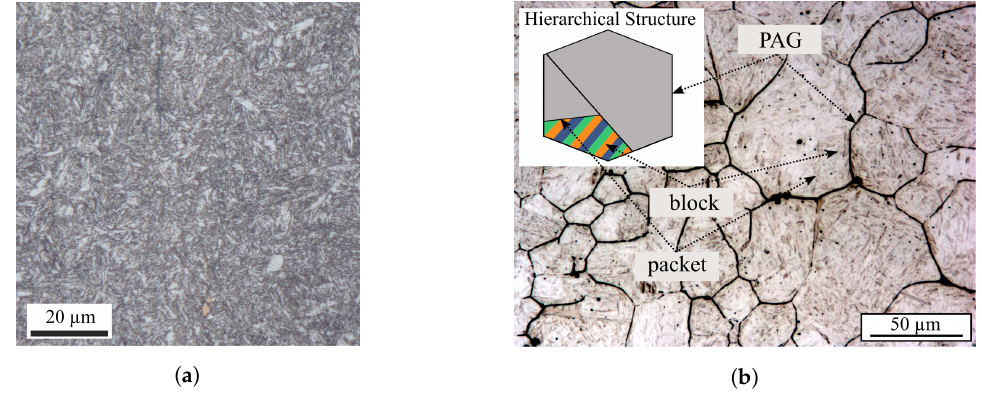
Figure 1. Light optical micrographs of the SAE 4150 microstructure. ( a ) Lath martensitic microstructure by nital etching. ( b ) Etching of the prior austenite grain boundaries by a picric acid based